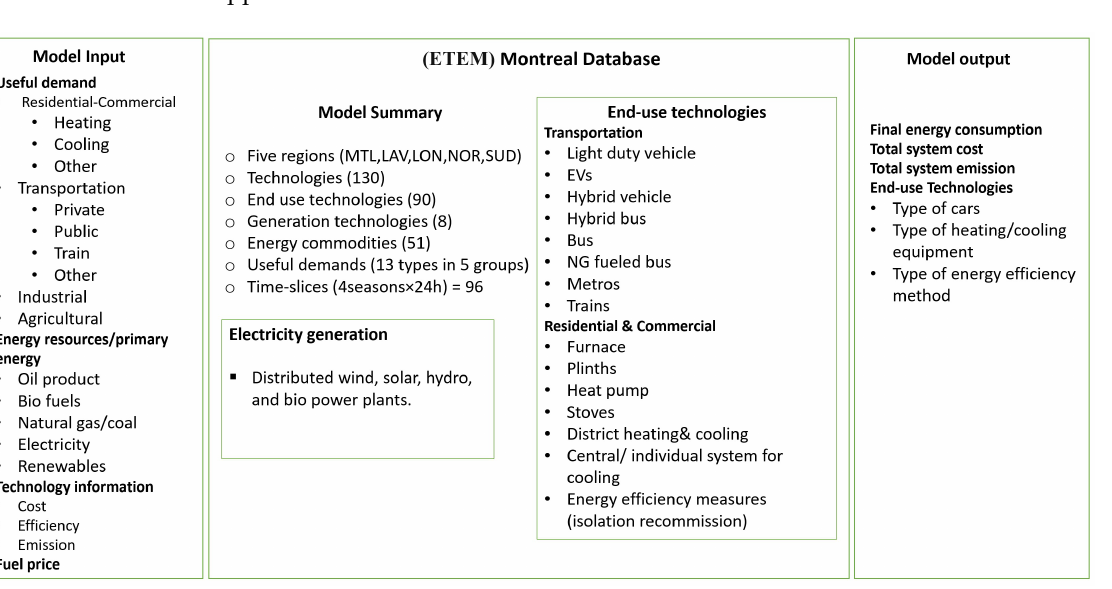
Figure 2. A summary of inputs, outputs, and the main characteristics of the ETEM adapted for the Greater Montreal